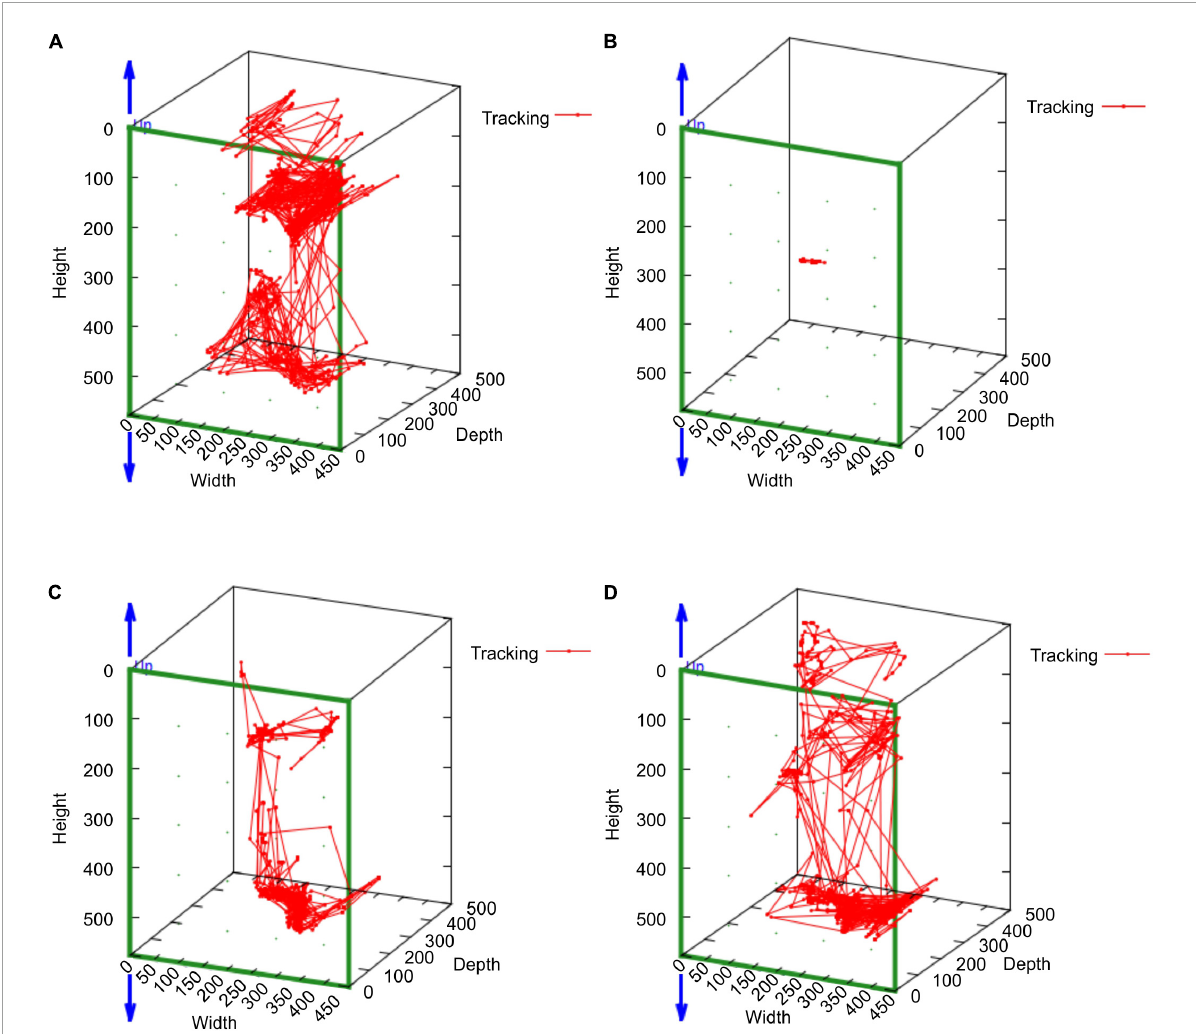
FIGURE5 The MarmoDetector analyses the trajectory of the marmoset in action Behavioral trajectory at a certain time: The marmoset (H123) was active in the cage at (A) the pre-operation stage. The range of moving trajectory was considerably limited on (B) the second postoperative day. It started enlarging on (C) the third postoperative day and (D) the fourth postoperative day.